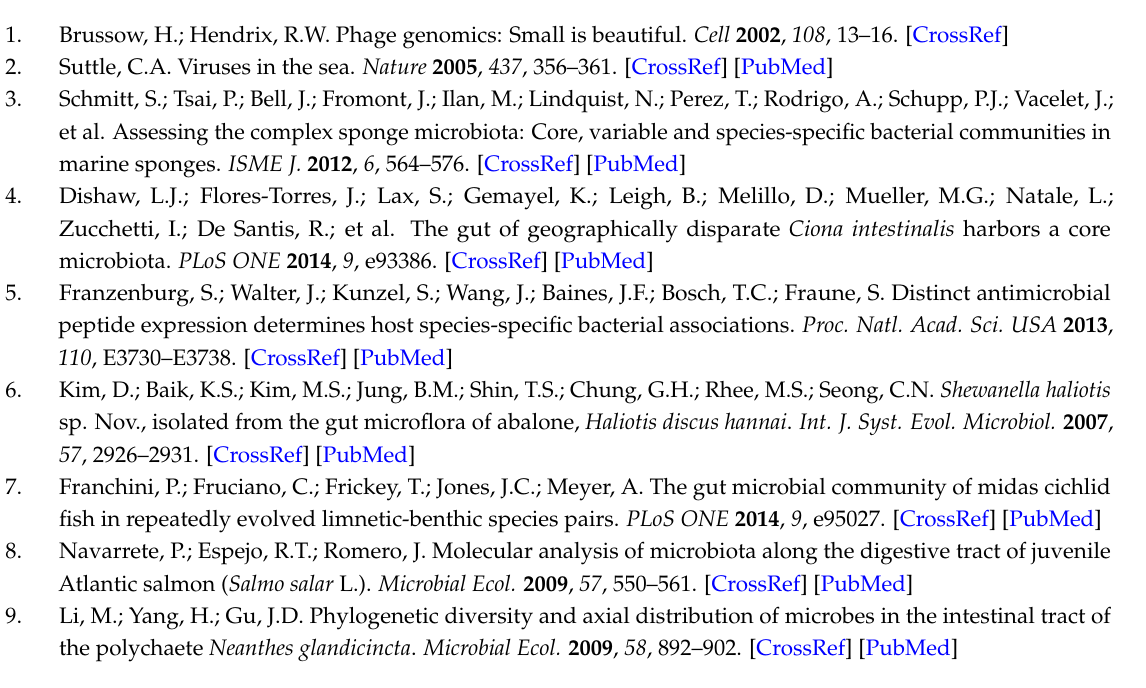
Figure S1: A PHYML-based tree (100 bootstrap replicates; 70% stringency) of Shewanella sp. 16S rRNA gene comparisons. Figure S2: Average nucleotide identity (ANI) comparison between the S. fidelis ATCC genome (GI:655363240) and S. fidelis 3313 as determined by the ANI Calculator (http://enve-omics.ce.gatech.edu/ani/); Figure S3: S. fidelis SFCi1 phage placement on phage proteomic tree. Table S1: ORF table for SFPat prophage; Table S2: ORF table for SFMu1 prophage; Table S3: ORF table for SFCi1 lytic